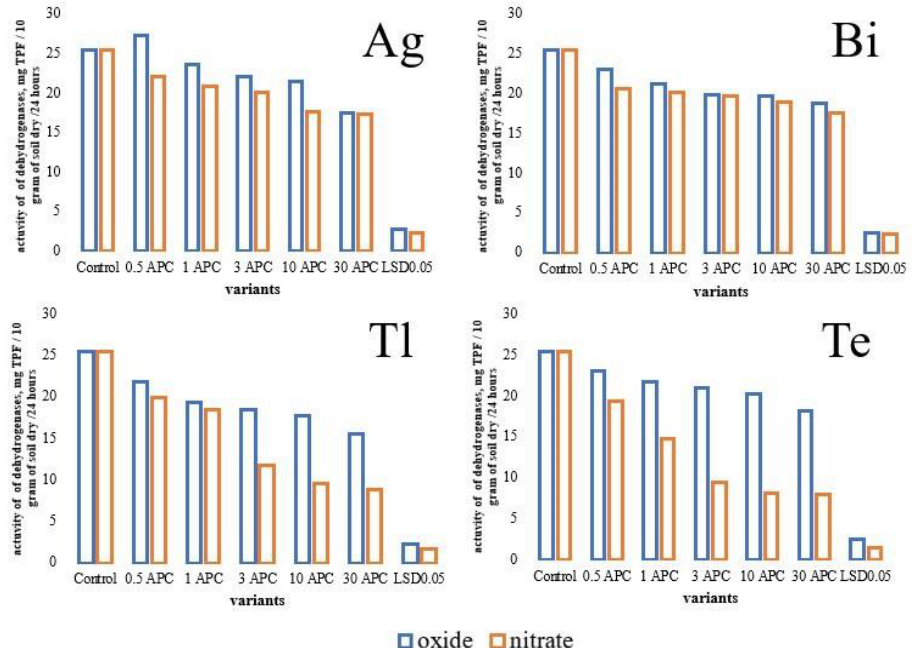
Figure 3. Changes in activity of dehydrogenases in haplic chernozem by contamination with oxides and nitrates of Ag, Bi, Tl, and Te, mg TPF/10 g of soil dry/24 h. With an increase in the concentration of Ag oxide to 1.3 and 10 APC, activity inhibition was 7, 13, and 15%, respectively. The maximum inhibition was observed at a concentration of 30 APC—32% lower than in the control. Ag nitrate had a more toxic effect on dehydrogenase activity: already at 0.5 APC, inhibition was 13% lower than the control, and with an increase in concentration from 1 to 30 APC, the change in activity was 18–32% lower than in the control.